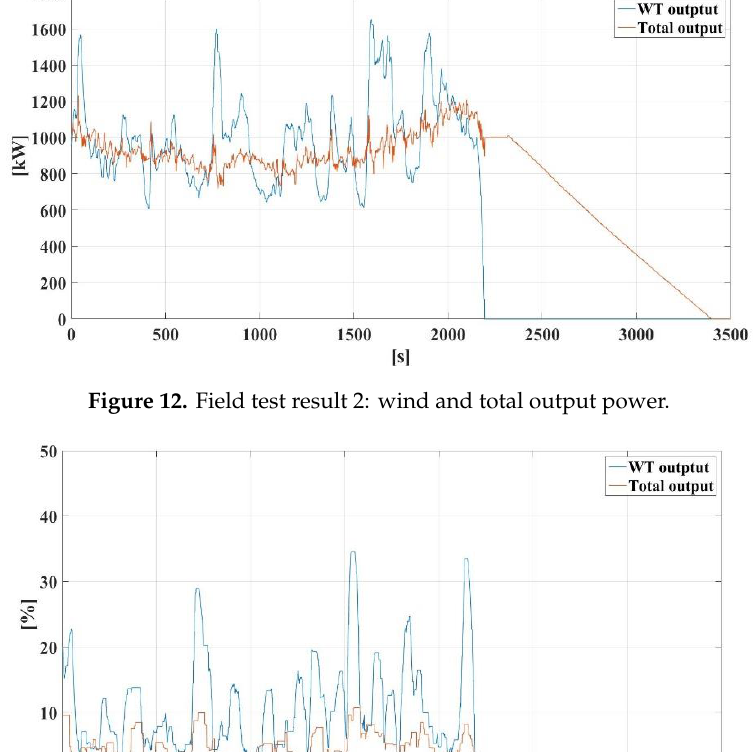
Figure 14. Field test result 2: output power of ESS.